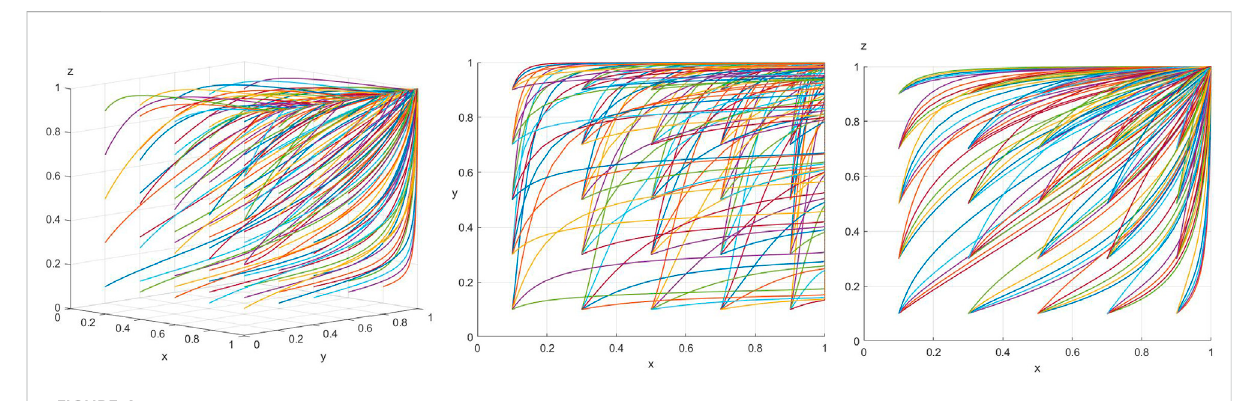
FIGURE 4 Results of the simulation evolution of array